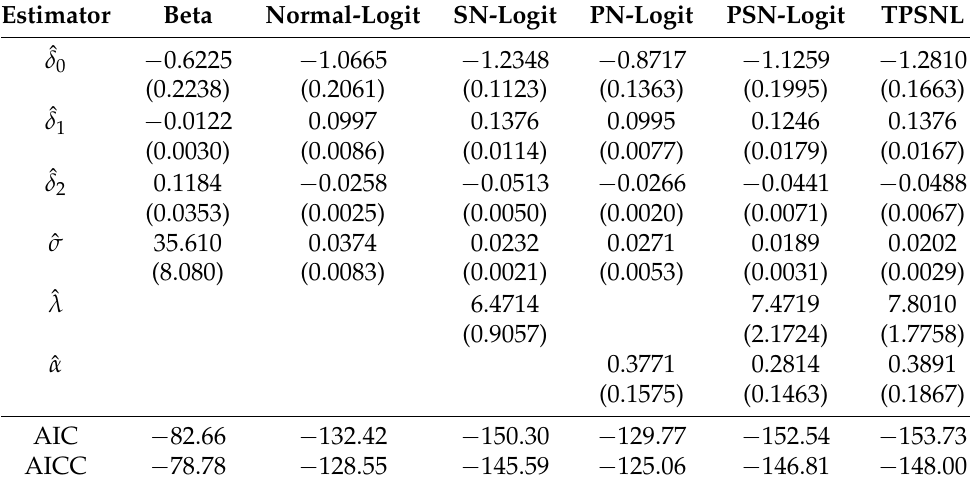
Table 1. Parameter estimates (standard errors) with logit link function for the normal, Beta, SN, PN PSN, and TPSN regression